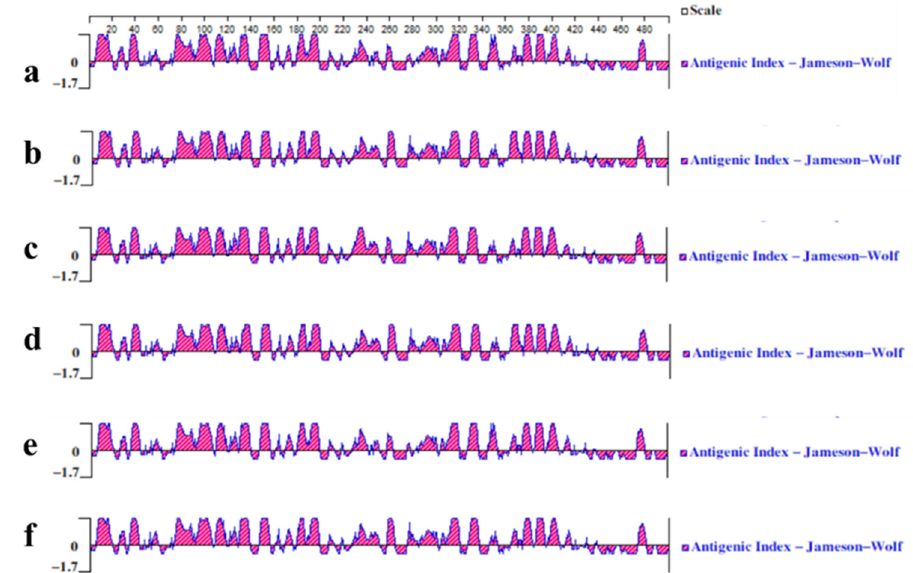
Figure 7. Antigenic index prediction of the E protein of JEV isolates. ( a ) CH/GD2011/2011; ( b ) CH/GD2015/2015; ( c ) CH/GD2014/2014; ( d ) CH/GD2018/2018; ( e ) CH/SA14-14-2 MSV/2018; and ( f ) CH/BJ-1/1995.